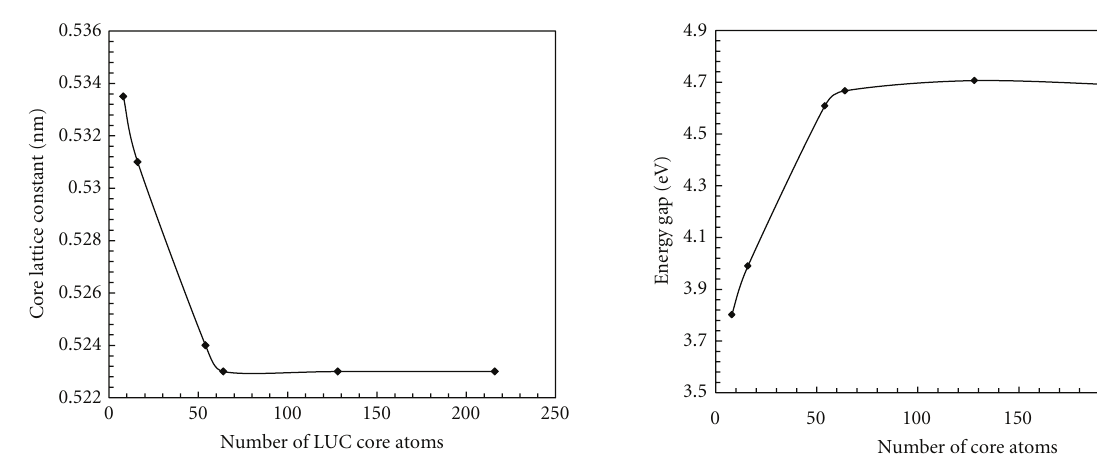
Figure 4: Energy gap of the core part of zb-AlP nanocrystals as a function of the number of core atoms.